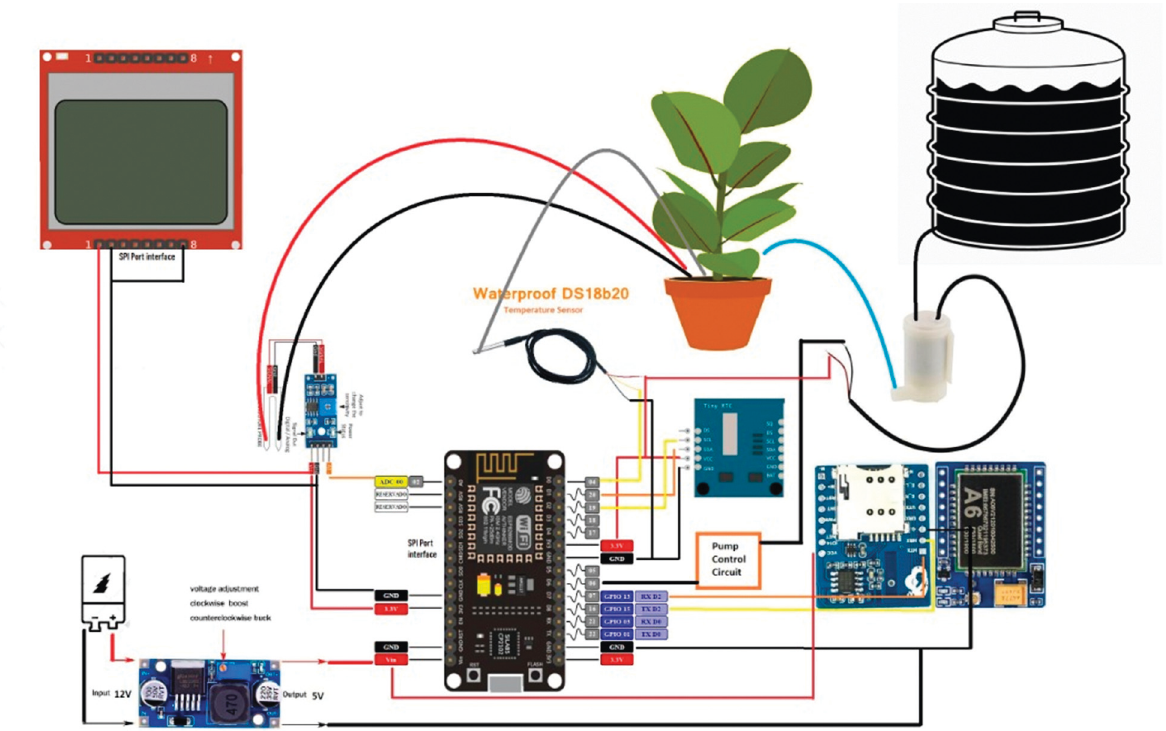
Figure 10: The block and circuit diagram of the SIS.